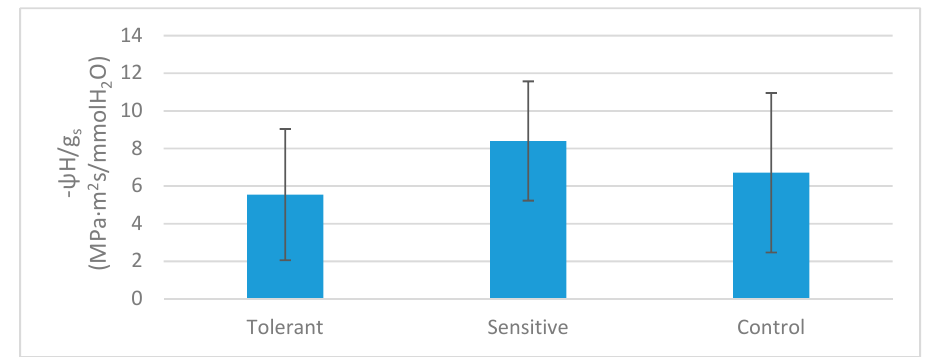
Figure 9. Ratio between water potential and gs in tolerant, sensitive, and control plants. Bars represent standard deviation.